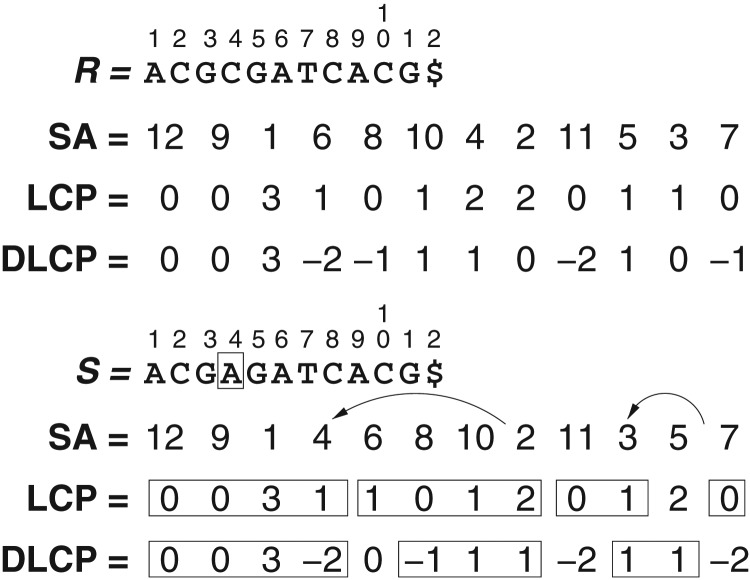
An example of our 𝖱𝖫𝖹 compression of 𝖣𝖫𝖢𝖯.